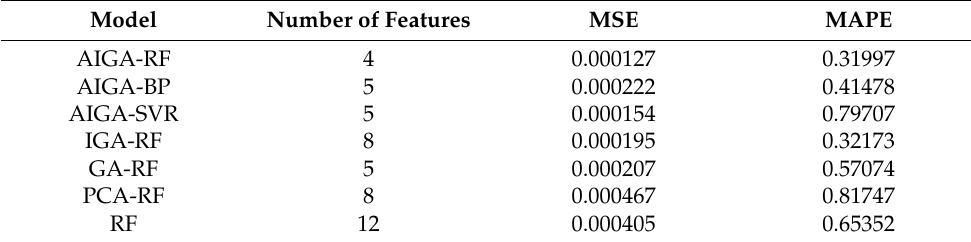
Table 3. Model comparisons based on MSE and MAPE.